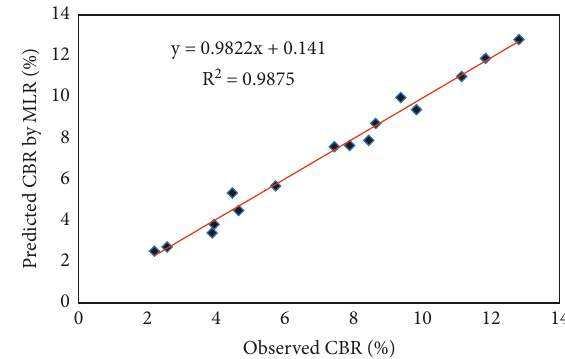
Figure 21: Predicted CBR by MLR versus experimental CBR.